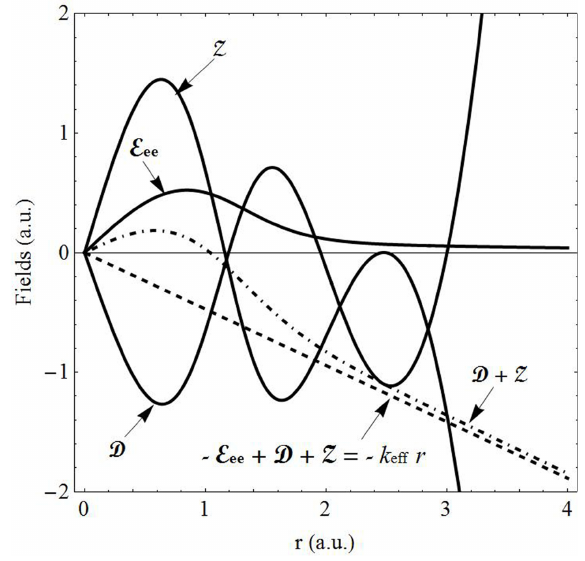
Figure 3. Same as in Figure 2 but for a quantum dot in a magnetic field in its first excited singlet state with k eff =